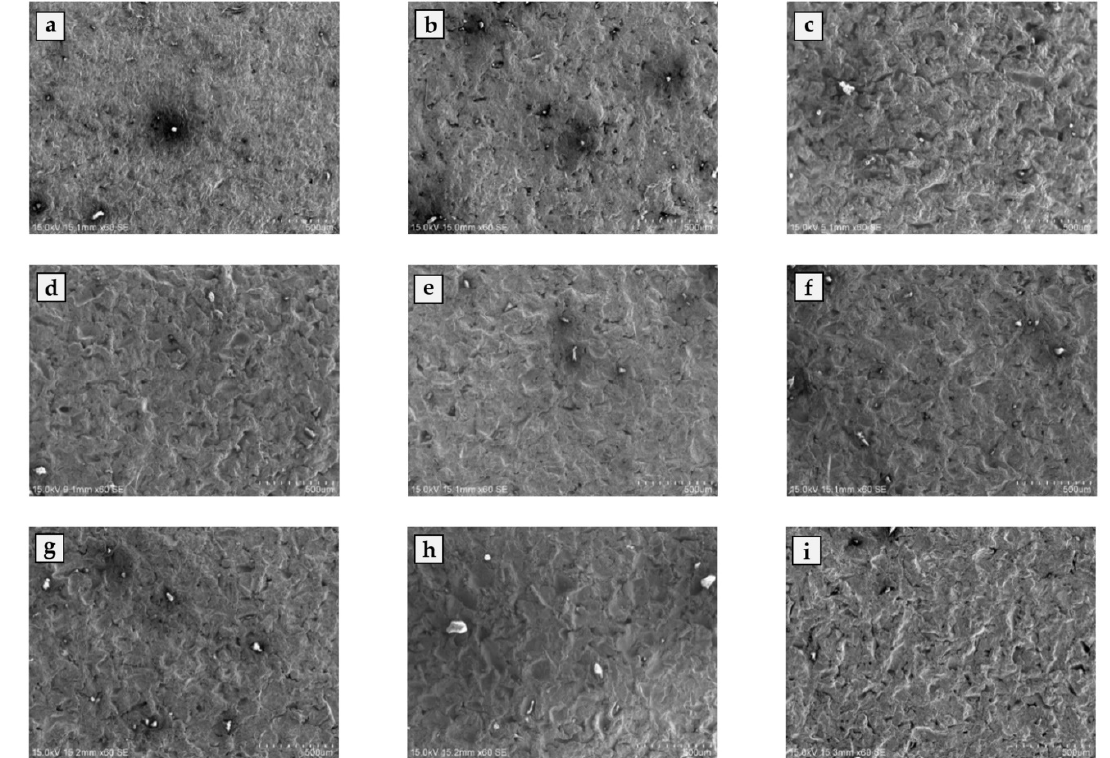
Figure 4. SEM images of abrasive waterjet textured surfaces at 60× for: ( a ) 0.1 mm and 5000 mm/min; ( b ) 0.1 mm and 7000 mm/min; ( c ) 0.1 mm and 9000 mm/min; ( d ) 0.3 mm and 5000 mm/min; ( e ) 0.3 mm and 7000 mm/min; ( f ) 0.3 mm and 9000 mm/min; ( g ) 0.45 mm and 5000 mm/min; ( h ) 0.45 mm and 7000 mm/min; ( i ) 0.45 mm and 9000 mm/min.